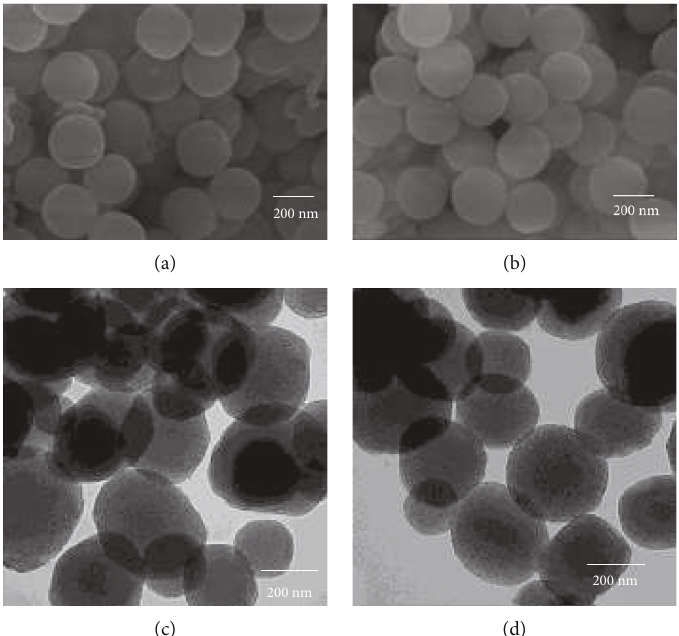
Figure 4: (a) and (b) SEM images of Asp-MSNs and Gly-MSNs, respectively. (c) and (d) TEM images of Asp-MSNs and Gly-MSNs,